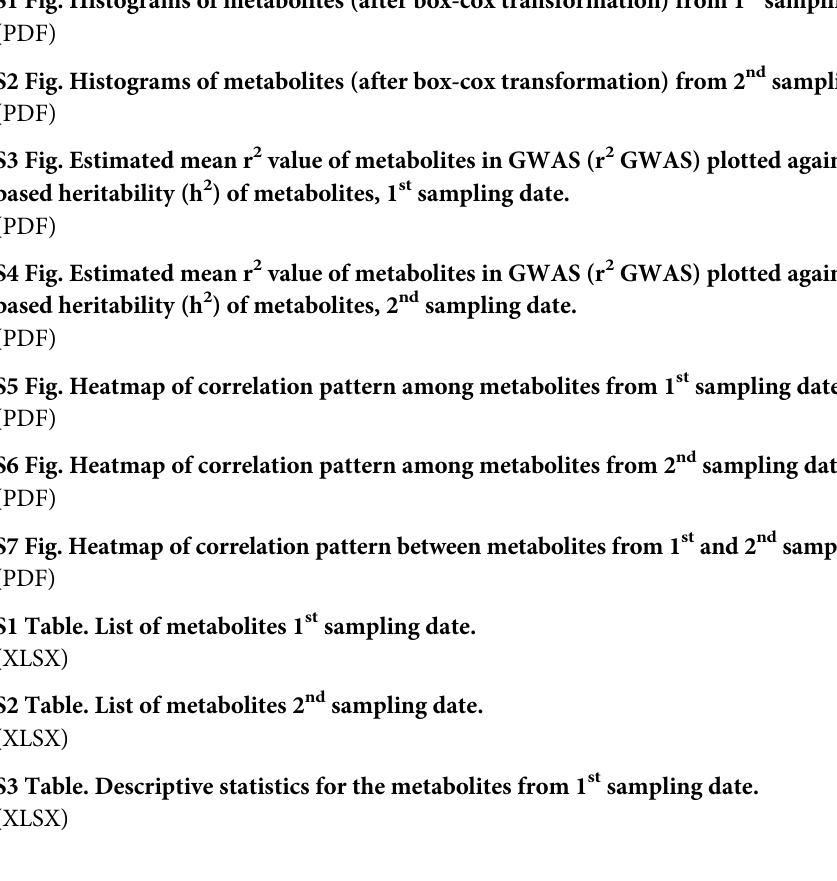
S1 Fig. Histograms of metabolites (after box-cox transformation) from 1 st sampling date. S2 Fig. Histograms of metabolites (after box-cox transformation) from 2 nd sampling date. S3 Fig. Estimated mean r 2 value of metabolites in GWAS (r 2 GWAS) plotted against SNP